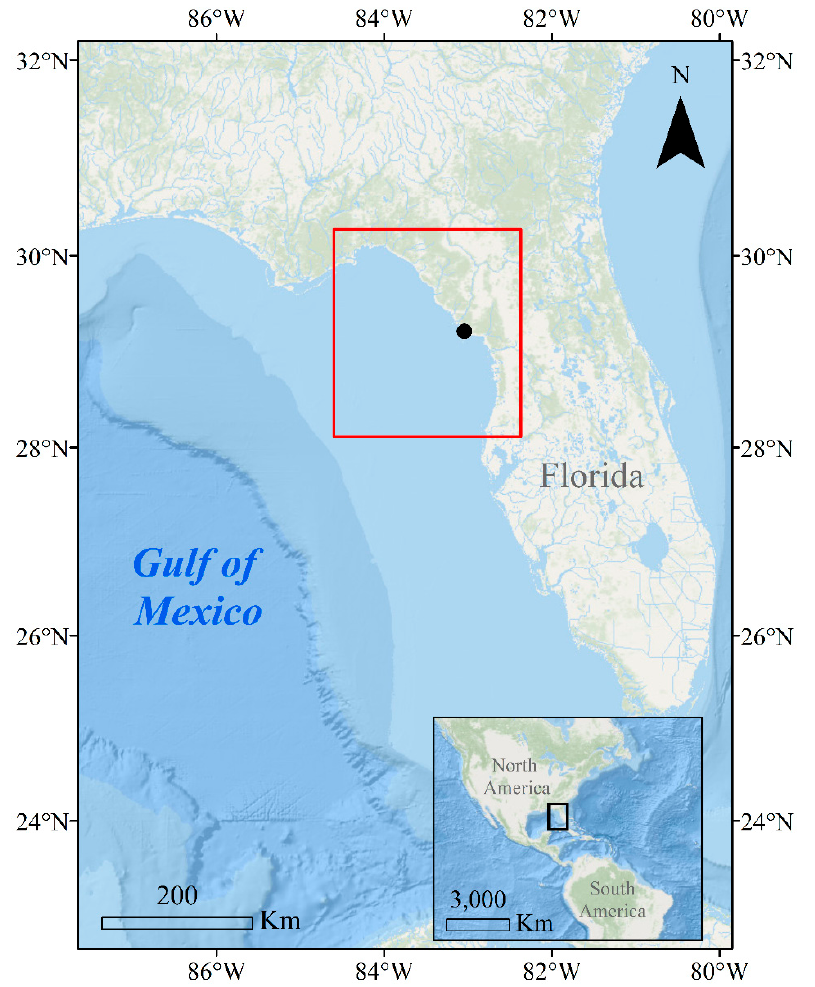
Figure 1. The area within the red rectangle represents Florida’s Big Bend coastline. The black dot represents the approximate location of the study site.